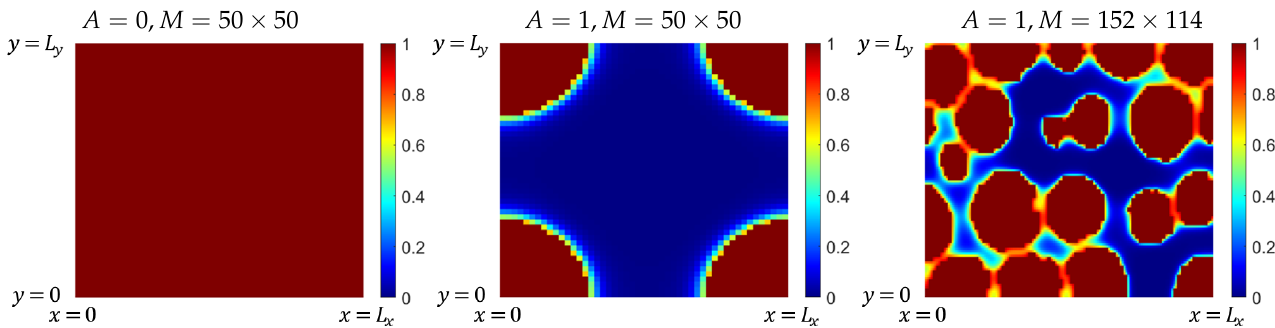
Figure 7. Contours of the attraction coefficient a ( x ) defined by (12j) in single–pore geometry and many-pore